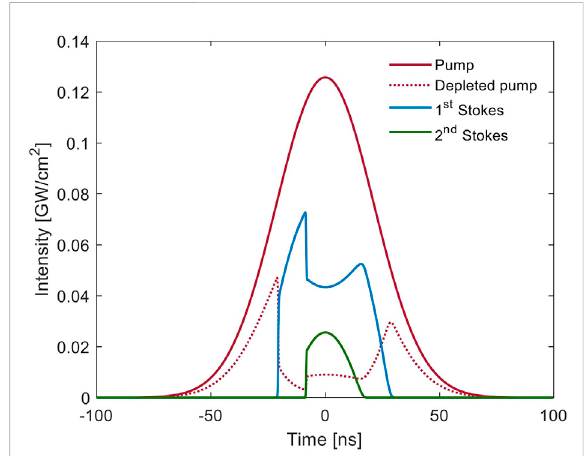
FIGURE 3 Example of the simulated depleted signal (dotted red) of a